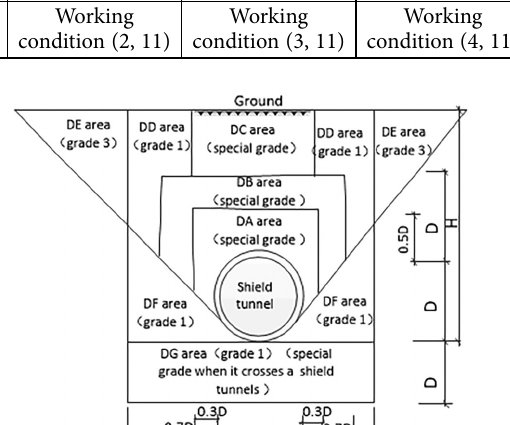
Figure 3. Grading diagram for working condition (1, 1)